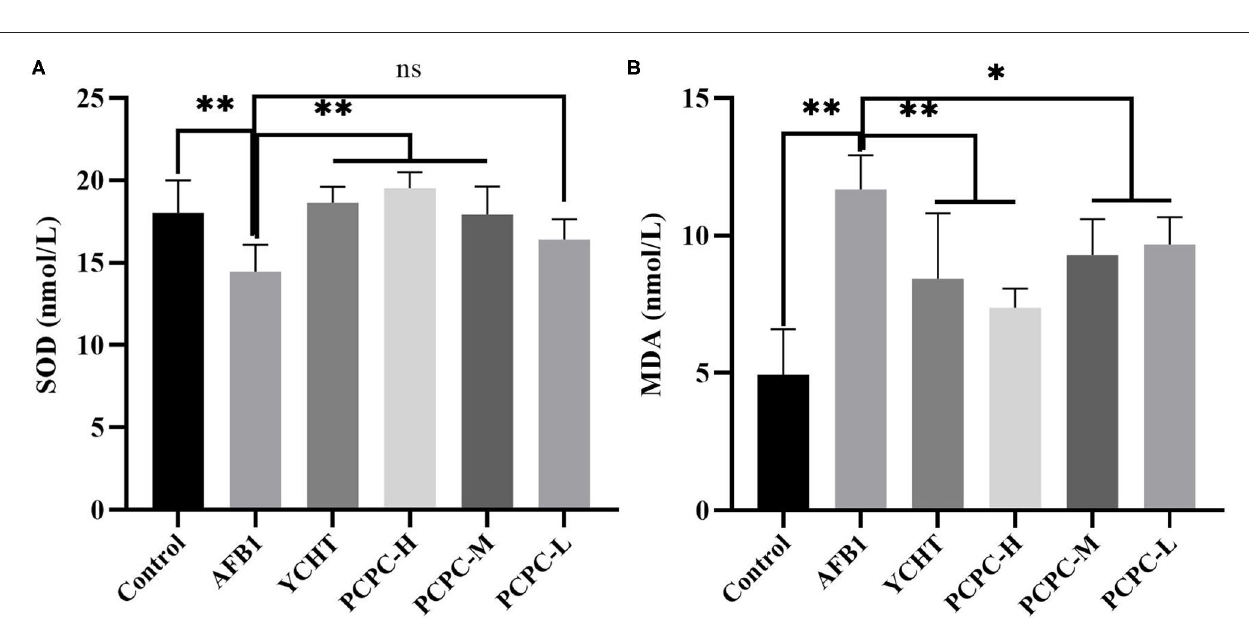
groups significantly enhanced the antioxidant enzyme activities in a dose-dependent manner by increasing SOD levels and decreasing MDA levels compared to those in AFB1-treated birds ( Figure 4 ).